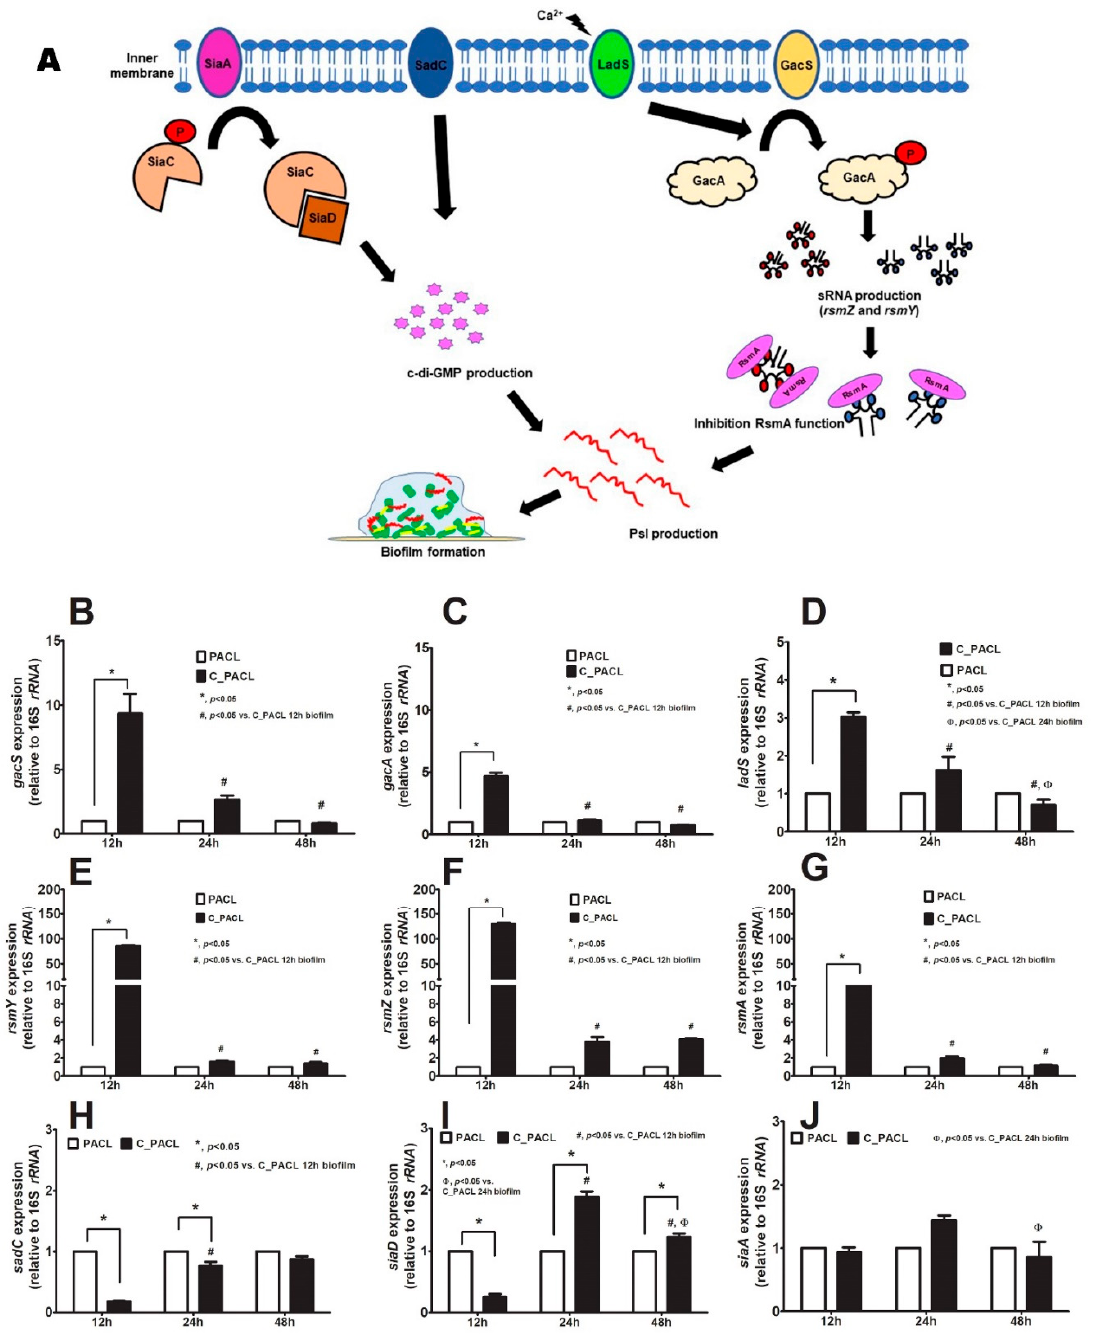
Figure 5. Diagram of Psl biosynthesis in P. aeruginosa with the bis-(3 ′ -5 ′ )-cyclic dimeric guanosine monophosphate (c-di-GMP)-dependent, using several diguanylate cyclases (SadC, SiaD, and SiaAC system) (left side) and c-di-GMP-independent pathways (using RsmA transcriptional regulator through rsmZ , rsmY , and LadS/GacSA) is demonstrated ( A ). Gene expression profiles in P. aeruginosa parent strain (PACL) and Chlorhexidine (CHG)-treated strain (C_PACL) biofilms in the c-di-GMP-independent pathway, including gacS ( B ), gacA ( C ), ladS ( D ), rsmY ( E ), rsmZ ( F ), and rsmA ( G ), and the c-di-GMP-dependent pathway, including sadC ( H ), siaD ( I ), and siaA ( J ) as determined by qRT-PCR are demonstrated (the experiments were performed in independent triplicate). Mean ± SEM are presented with the one-way ANOVA followed by Tukey’s analysis (*, p ˂ 0.05; # , p ˂ 0.05; and Φ , p ˂ 0.05).